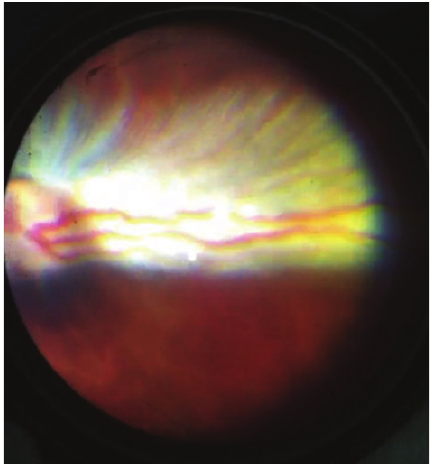
Figure 7: Control rabbit